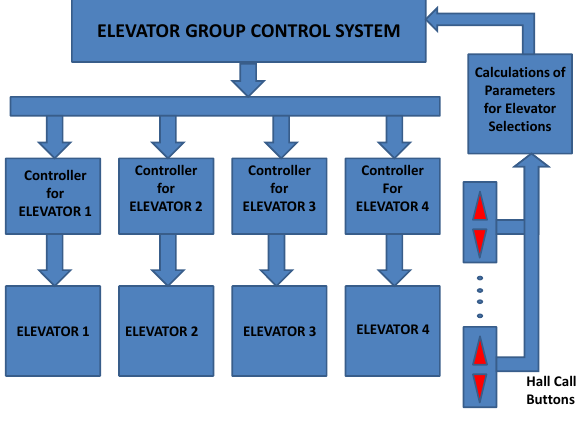
Figure 1. Block diagram of